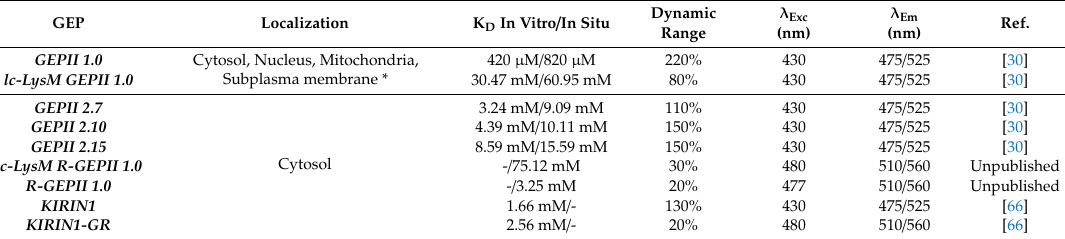
* indicates that the probes were fused to specific targeting sequences to obtain the given localizations,